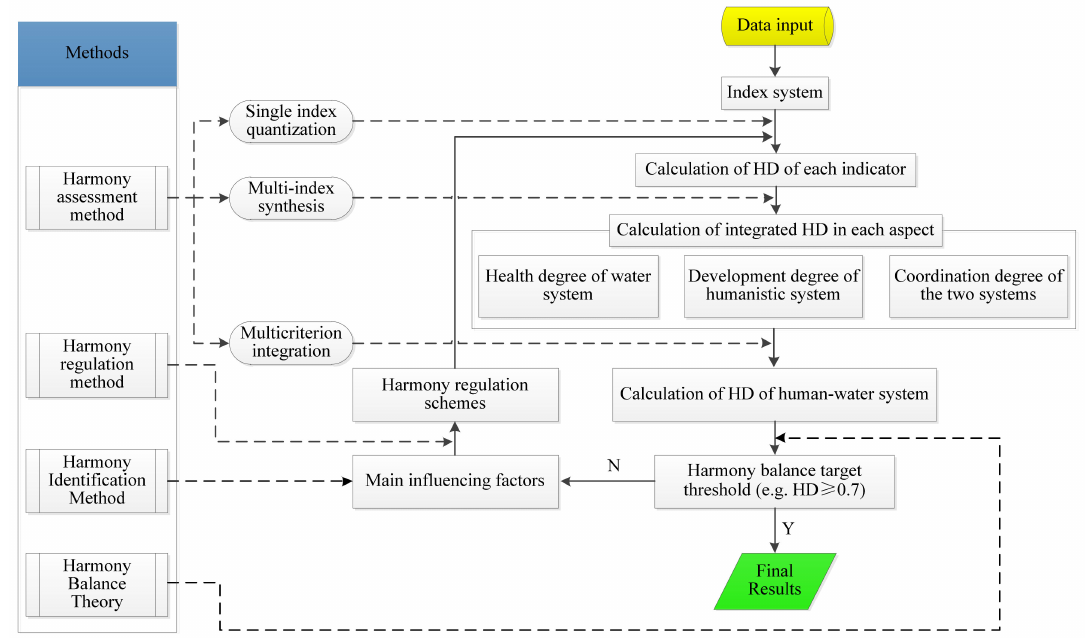
Figure 1. Research framework for assessing and regulating the harmonious relationship of the human–water